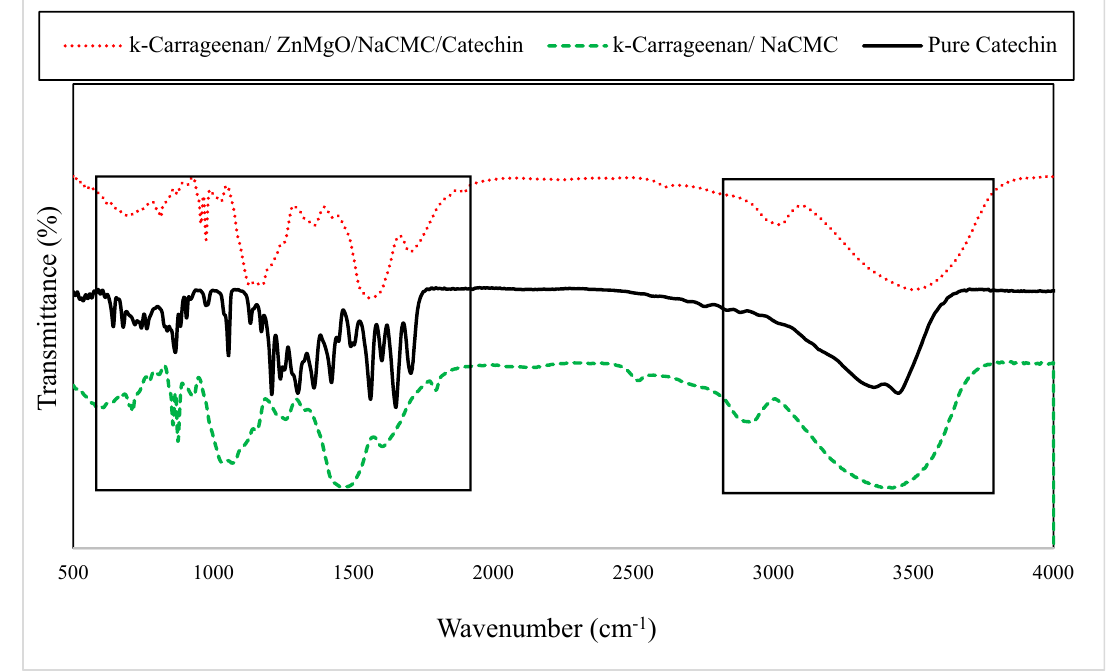
Figure 7. FTIR spectra of κ -Carrageenan/ Mg 0.99 Zn 0.01 O /NaCMC/Catechin, κ -Carrageenan/NaCMC, and pure (+)-catechin .